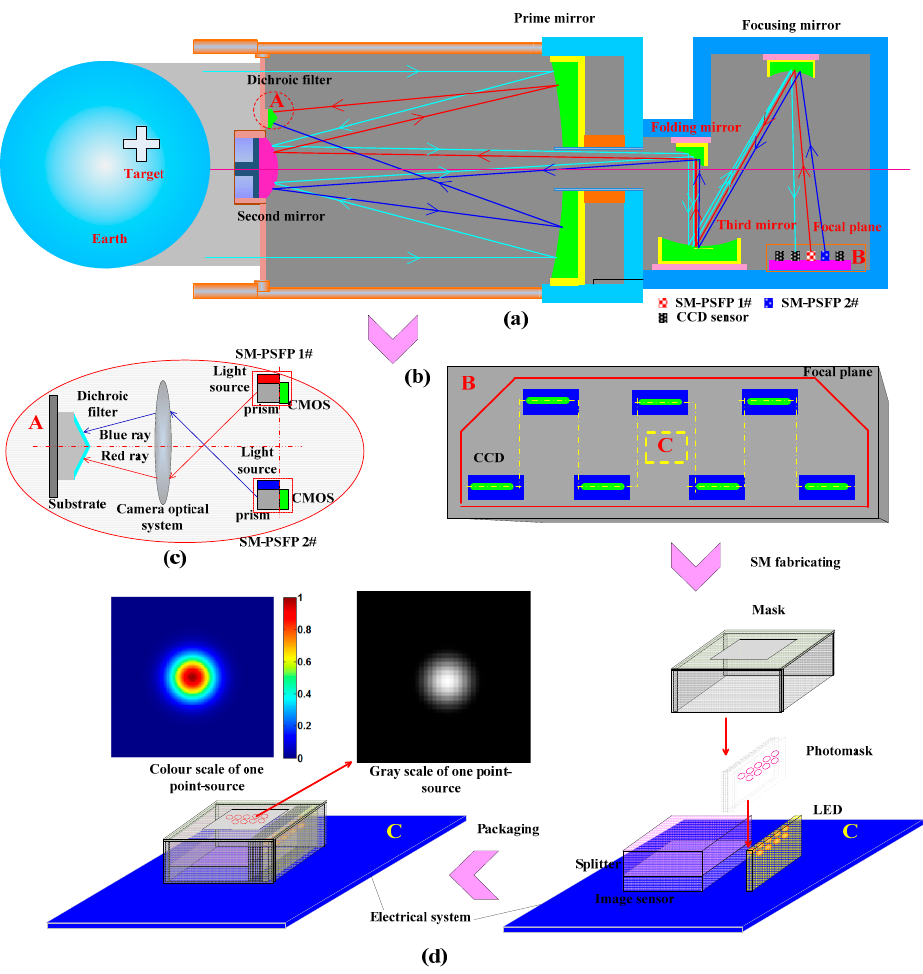
Figure 1. Principle of self-calibration: ( a ) the internal structure of remote sensing camera; ( b ) the optical plane of remote sensing camera; ( c ) the equivalent light path of dichroic filter; and ( d ) the light transceiver focal plane for calibrating IOPs.